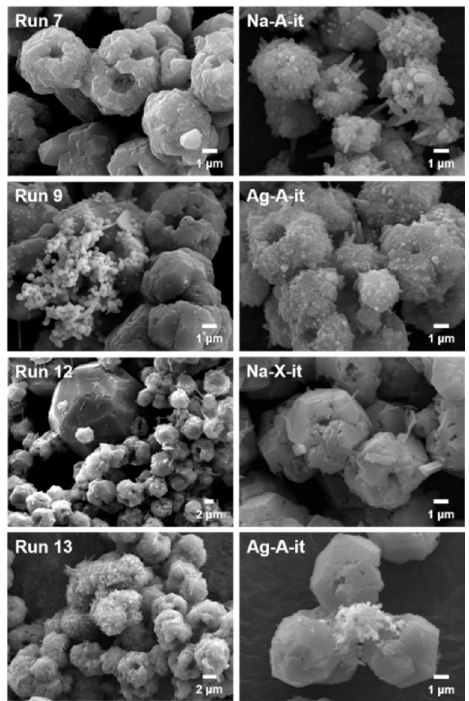
Figure 3. SEM images of the representative products synthesized by the interzeolite transformation of Na-A and Na-X (left), and the interconversion products of CH 3 I adsorbed Na-A, Ag-A, Na-X, and Ag-X (right).